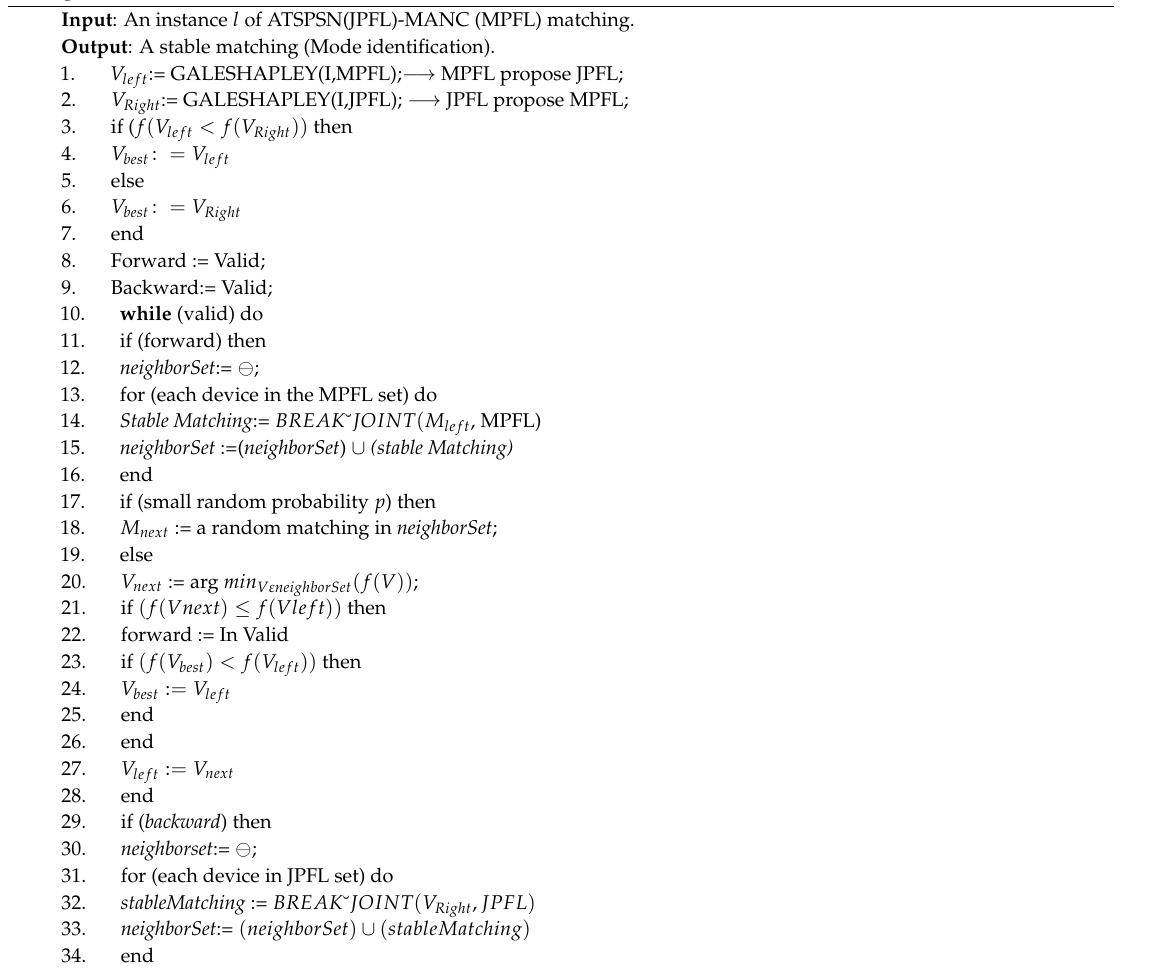
Algorithm 5: JAMANC